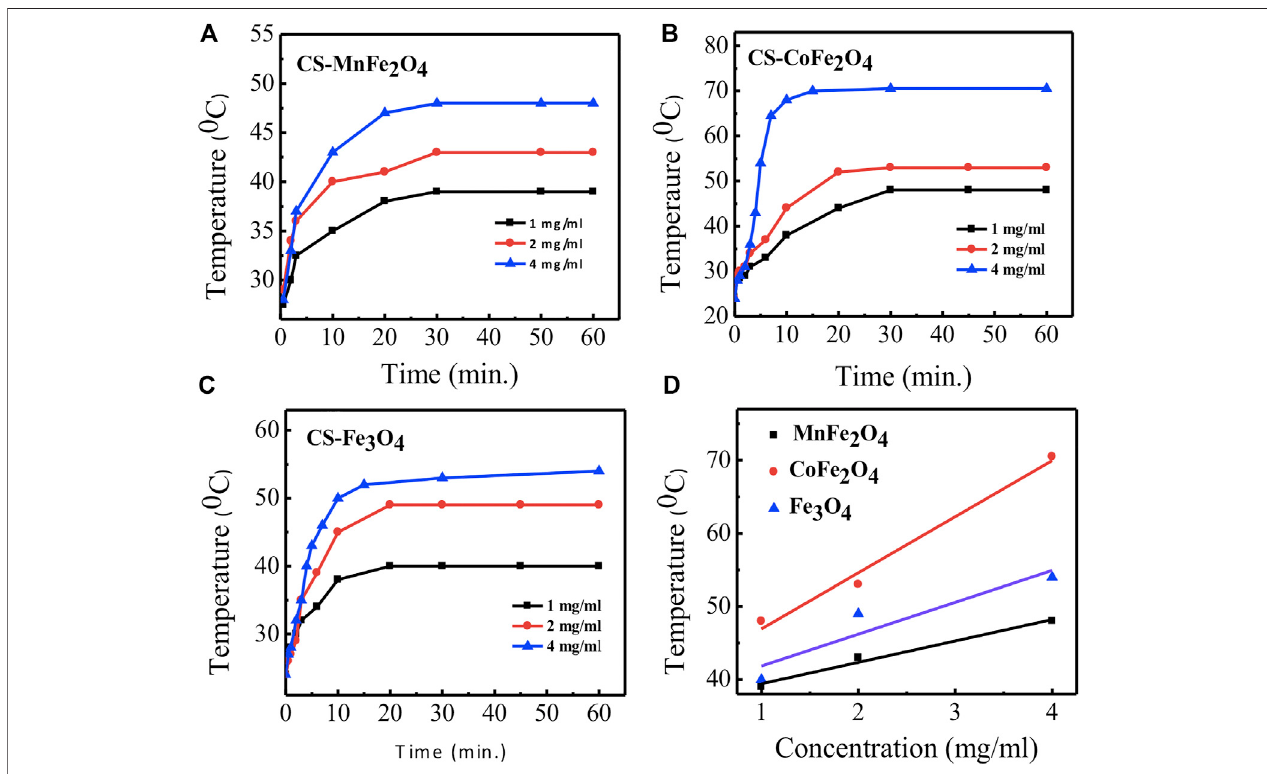
FIGURE 8 | Time dependence of temperature rise of particles at a concentration of 1, 2, and 4 mg/ml in water for different compositions coated with chitosan (A) MnFe 2 O 4 (B) CoFe 2 O 4 (C) Fe 3 O 4 (D) linear fi ttinggraphsofconcentrationdependence oftemperatureriseofparticlesfordifferentcompositionscoatedwithchitosanby using the radio frequency fi eld of 400 kHz and 76 mT for 60